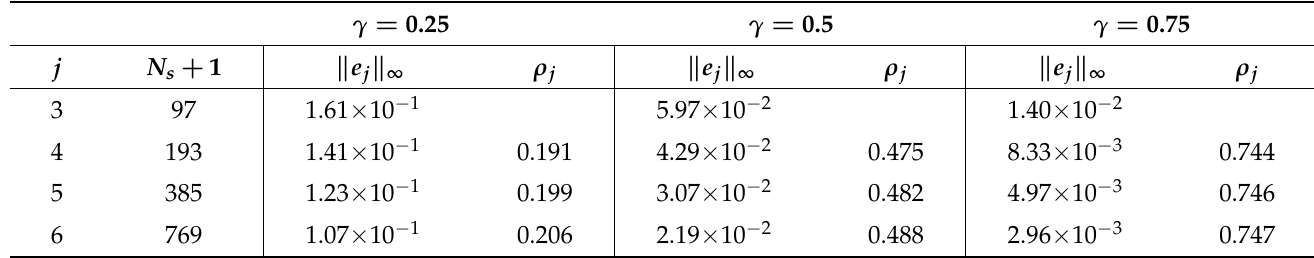
Table 4. Example 2: The infinity norm of the error and the numerical convergence order for different values of the fractional derivative γ and the refinement level j when using dQ 3 j y with r = 1 (cf. (26)). The number of collocation points is N s + 1 = 2 j 6 + 1.